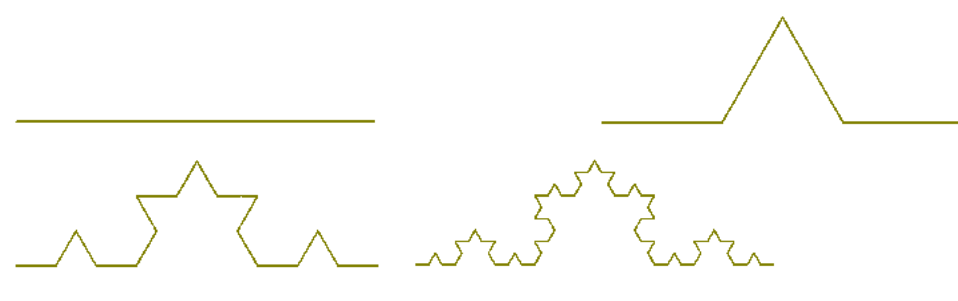
Figure 18. Four stages of Koch fractal.